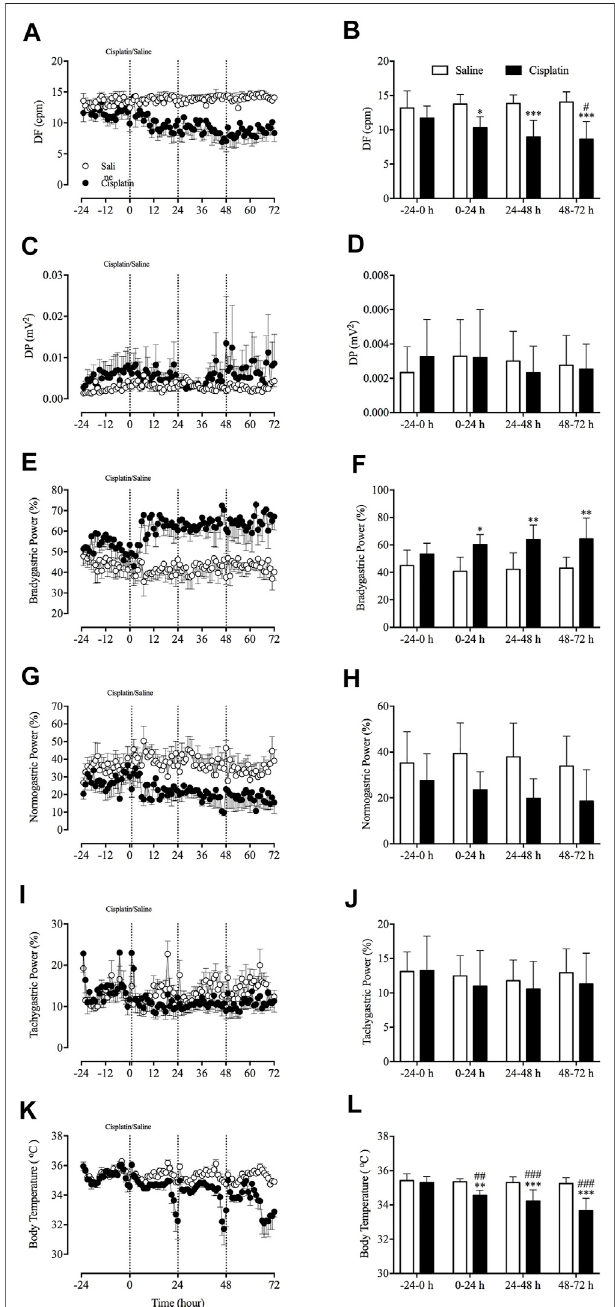
FIGURE 3 | Effect of cisplatin (30 mg/kg, intraperitoneal) on gastric myoelectric activity in Suncus murinus . (A) The dominant frequency (DF); (B) the change in the DF averaged over 24 h; (C) the dominant power (DP); (D) the changeintheDPaveragedover24 h; (E) bradygastria(%); (F) thechangein bradygastria averaged over 24 h; (G) normogastria (%); (H) the change in normogastria averaged over 24 h; (I) tachygastria (%); (J) the change in tachygastria averaged over 24 h; ( K) body temperature; and (L) the change in body temperature averaged over 24 h cpm (cid:1) cycles per min. Data are means ± standard errors of the mean for n (cid:1) 7 – 8 animals. Signi fi cant differencesrelative to baseline (-24 – 0 h) in the groups are shown as # p < 0.05, ## p < 0.01, ### p < 0.001[two-wayanalysisofvariance(ANOVA)followedbyBonferronitests]. Signi fi cant differences between cisplatin and saline groups are shown as * p < 0.05, ** p < 0.01 or *** p < 0.001 (two-way ANOVA followed by Bonferroni tests).